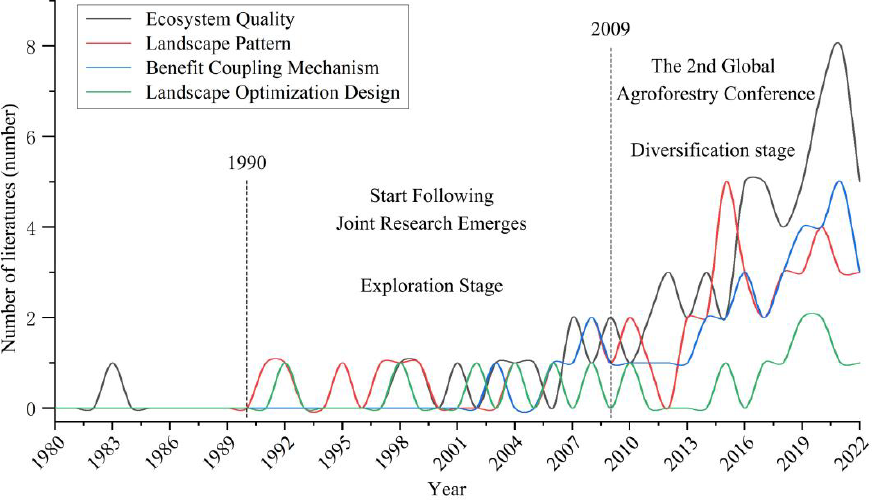
Figure 5. Research hotspots annual issue volume changes (from 1983 to 30 June 2022).